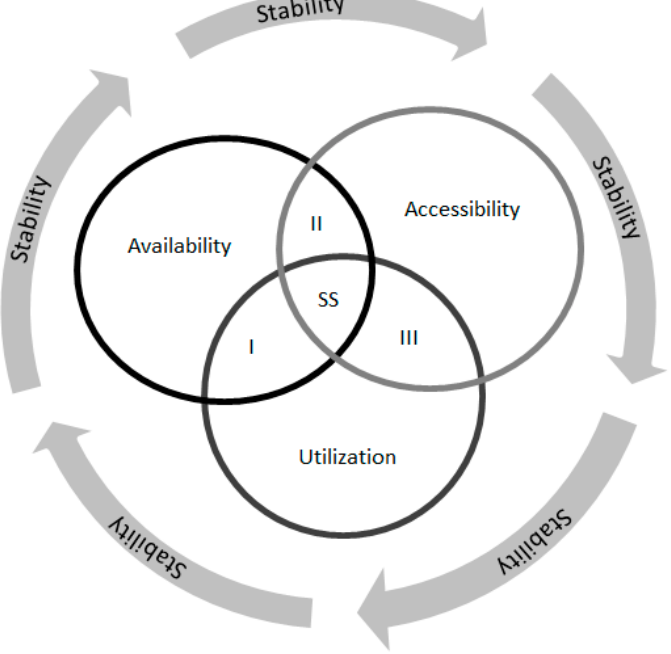
Figure 1. Conceptual relationships and interactions of the dimensions of soil security. Note: SS denotes soil security.